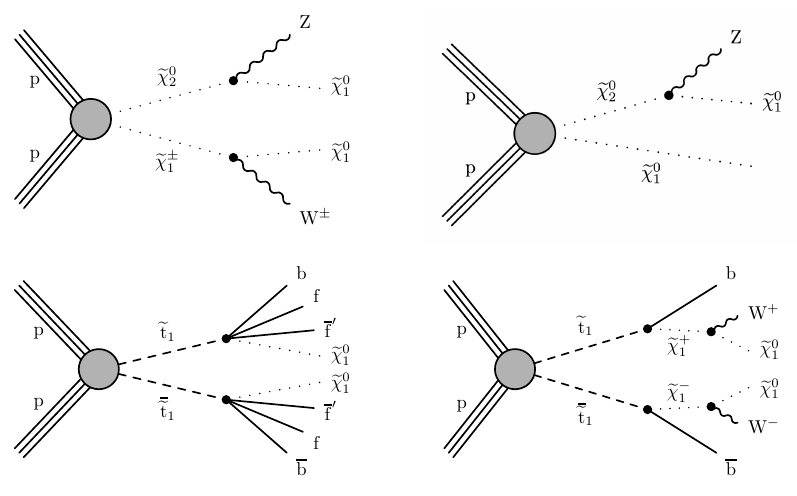
Figure 1 . Production and decay of electroweakinos in the TChiWZ model (upper left), in the higgsino simplified model (upper left and right), in the T2b ff T2bW model (lower